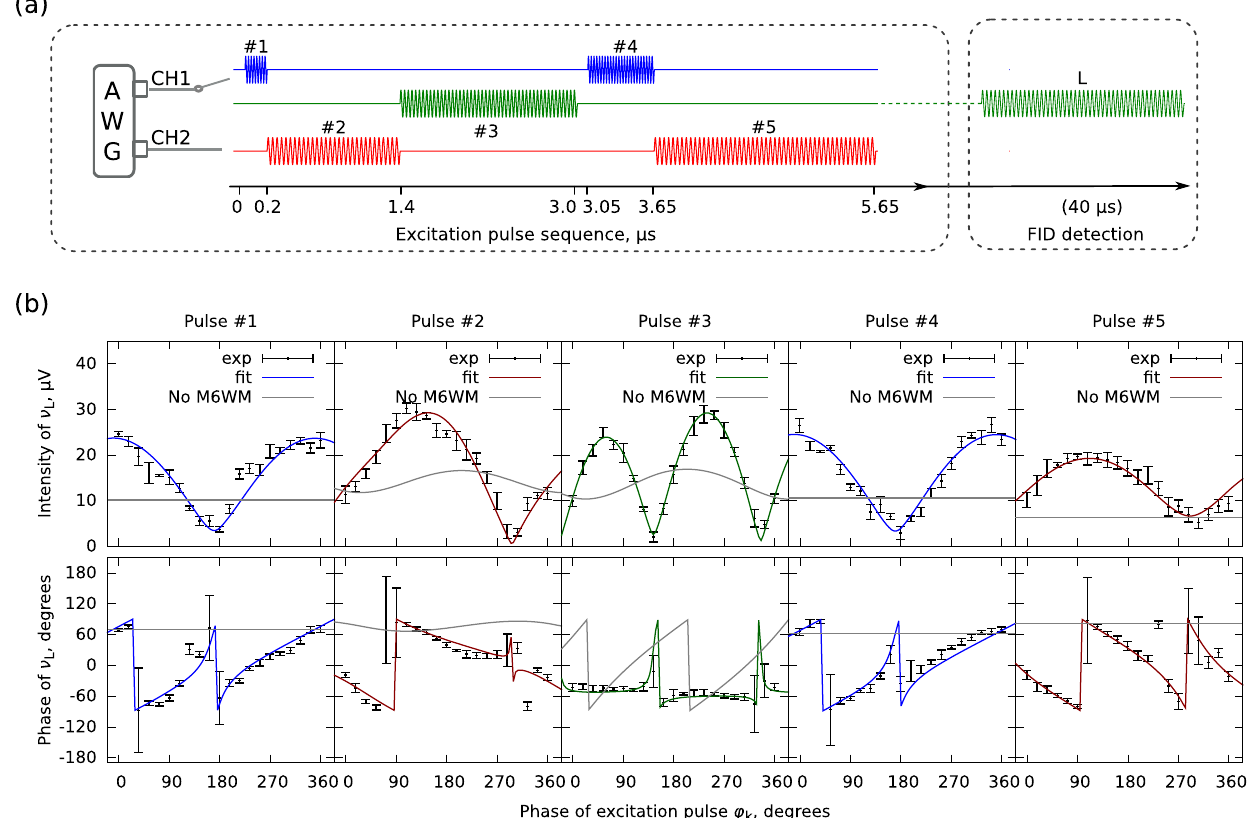
Fig. 3 | M6WM spectroscopy of BA. a The experimental M6WM pulse sequence, where the colors of the microwave pulses match the laboratory frame as in Fig. 2. The durations correspond to an optimized π /2-pulse for pulse #1 and π -pulses for pulses #2 – #5. 40 μ s of FID for the frequency of the listen transition ( ν L ) was recordedafterthe fi veexcitationpulses,thedurationofwhichisnottoscale. b The resultingphasedependencepatternsinamplitude (top)and phase(bottom)atthe listentransition( ν L ).Theywereobtainedbyindividuallyscanningthephasesofthe correspondingpulses( φ k )andmeasuringtherespectiveamplitudeandphaseof ν L at 5283.64MHz. Here, “ phase of ν L ” denotes the arctangent of the tangent of the